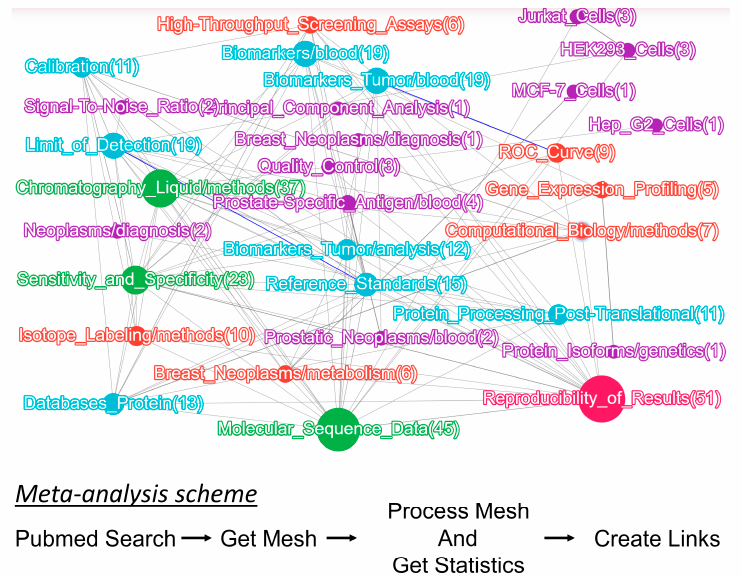
Figure 1. Results of the search for publications reporting the selected/multiple reaction monitoring (SRM/MRM) data for humans over the past ten years (2012–2022) using the ScanBious system. The size of the nodes reflects the occurrence of the keywords in the abstracts. The identified key clusters involve search terms related to tumor biomarkers, their sensitivity, specificity, and reproducibility. Of note, SRM analysis was frequently used to study cancer cell lines, such as Jurkat, MCF-7, and